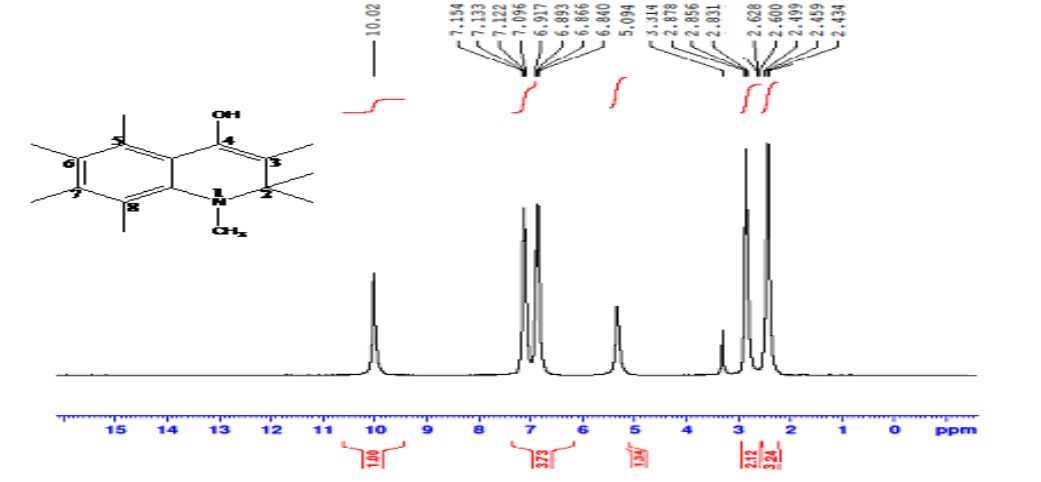
Figure 7 : 1 H-NMR analysis of the isolated E2 compound.